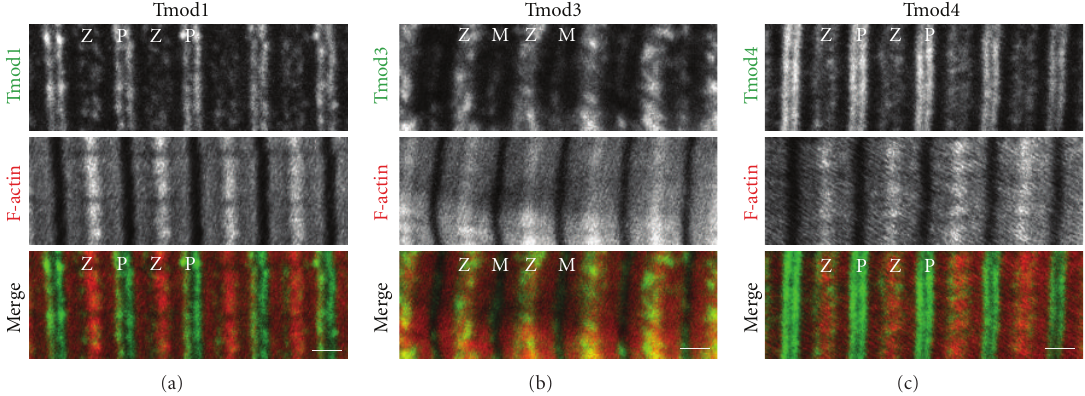
Figure 2: Immunofluorescence localization of Tmods in skeletal muscle. Panels depict longitudinal cryosections of mouse tibialis anterior muscle immunostained for (a) Tmod1, (b) Tmod3, or (c) Tmod4, phalloidin-stained for F-actin, and imaged by confocal microscopy, prepared as in [31, 63]. Note the predominant localization of Tmod1 and Tmod4 at the pointed ends of the phalloidin-stained thin filaments. Tmod1 and Tmod4 also exhibit Z-line-flanking localizations, corresponding to an SR- or T-tubule-associated compartment. By contrast, the M-line and Z-line-flanking localization of Tmod3 is a signature of the SR [63]. Z, Z-line; M, M-line; P, thin filament pointed ends. Bars, 1 μ